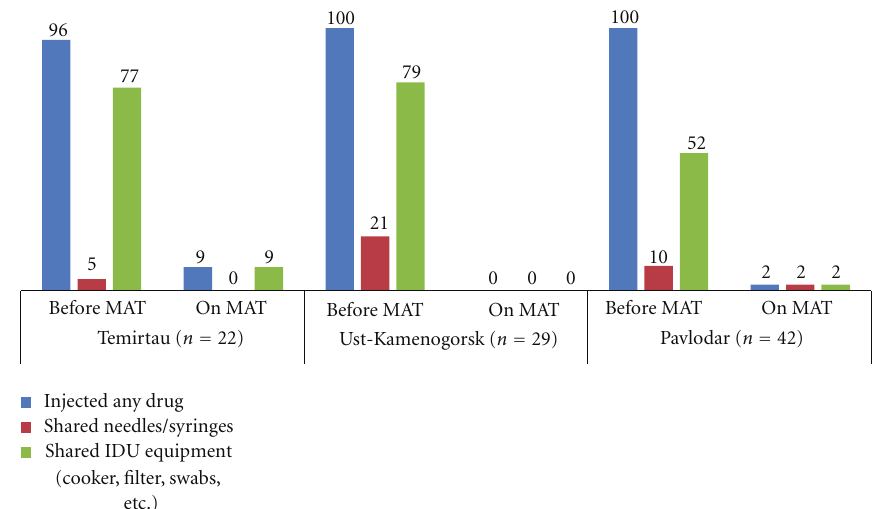
Figure 5: Drug injection practices, in %.